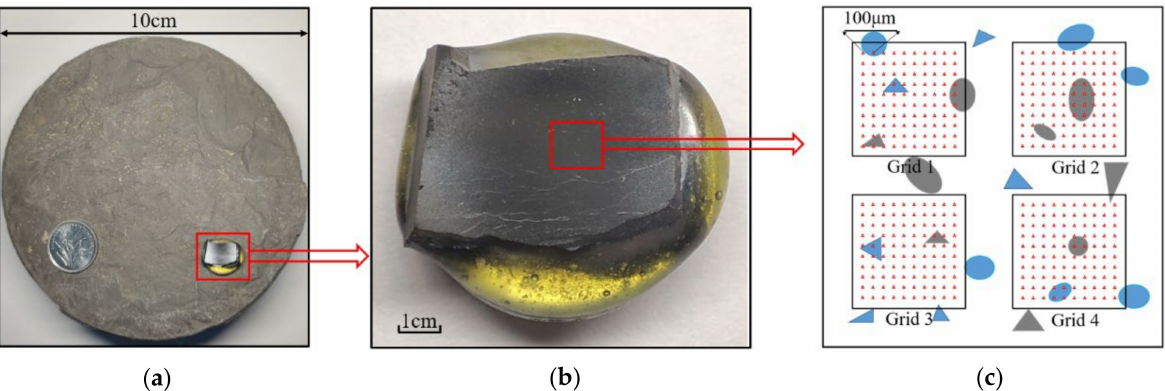
Figure 2. Schematic diagram of sample acquisition: ( a ) full diameter core, ( b ) shale rock sample for nanoindentation, ( c ) schematic diagram of grid